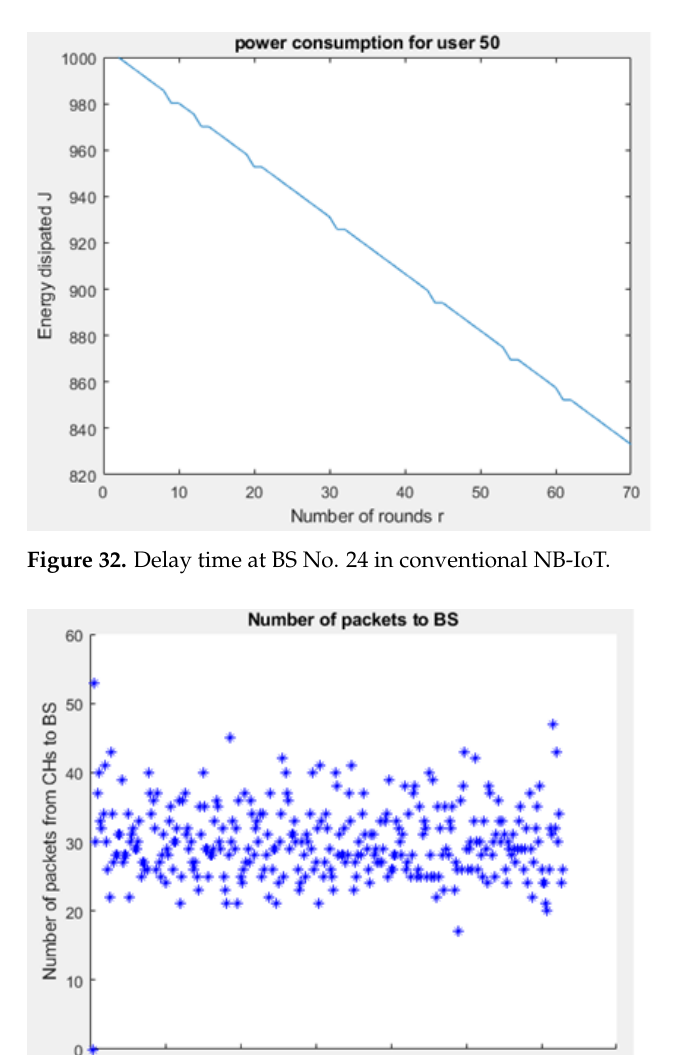
Figure 31. Delay time at BS No. 24 in proposed NB-IoT D2D framework.